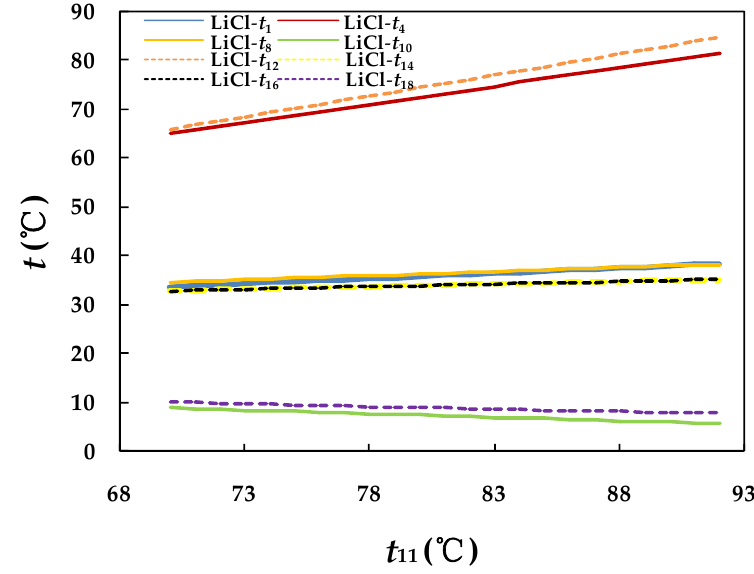
Figure 14. Variations of the exit temperatures of the internal and external fluids with hot water inlet temperature for the LiBr-H 2 O absorption chiller.